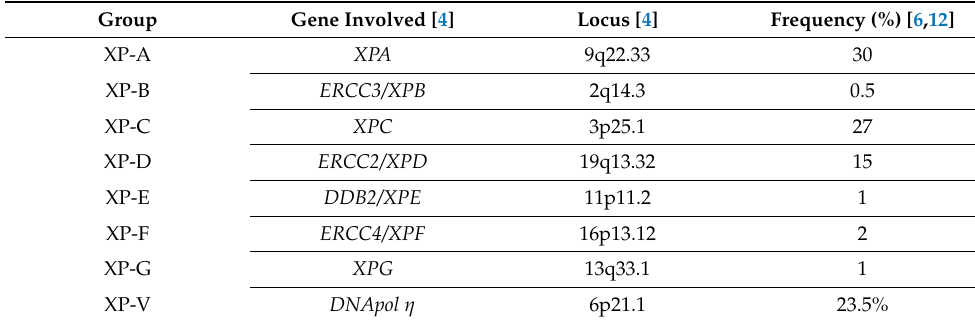
Table 1. Loci and genes associated with XP complementation groups and XP variant.